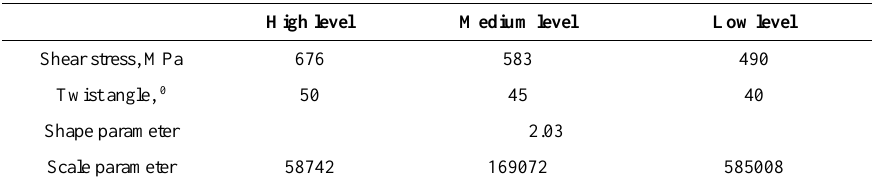
Table 7. Values of scale parameter for each stress